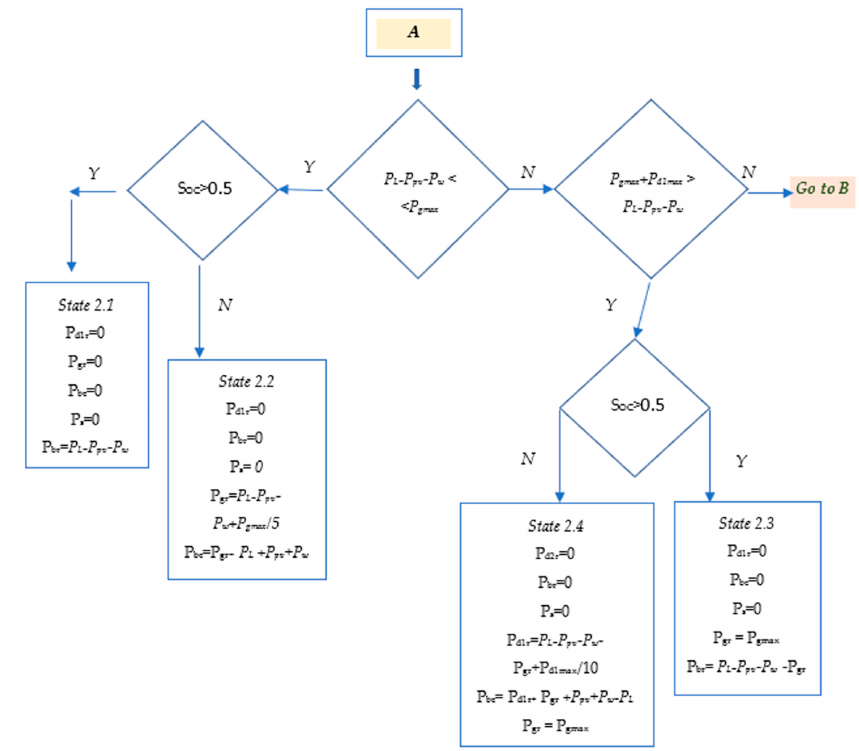
Figure 5. Flow Chart of States and transitions (1 of 3).